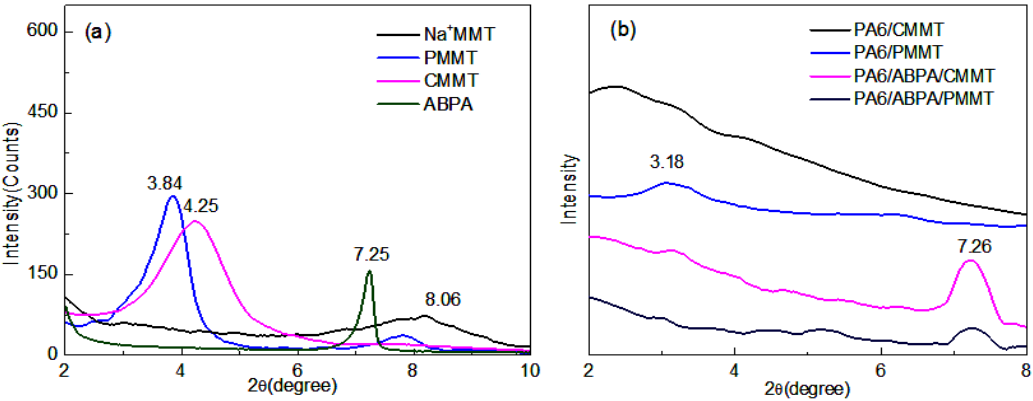
Figure 1. XRD spectra for ( a ) OMMT and flame retardant; ( b ) PA6 nanocomposites.